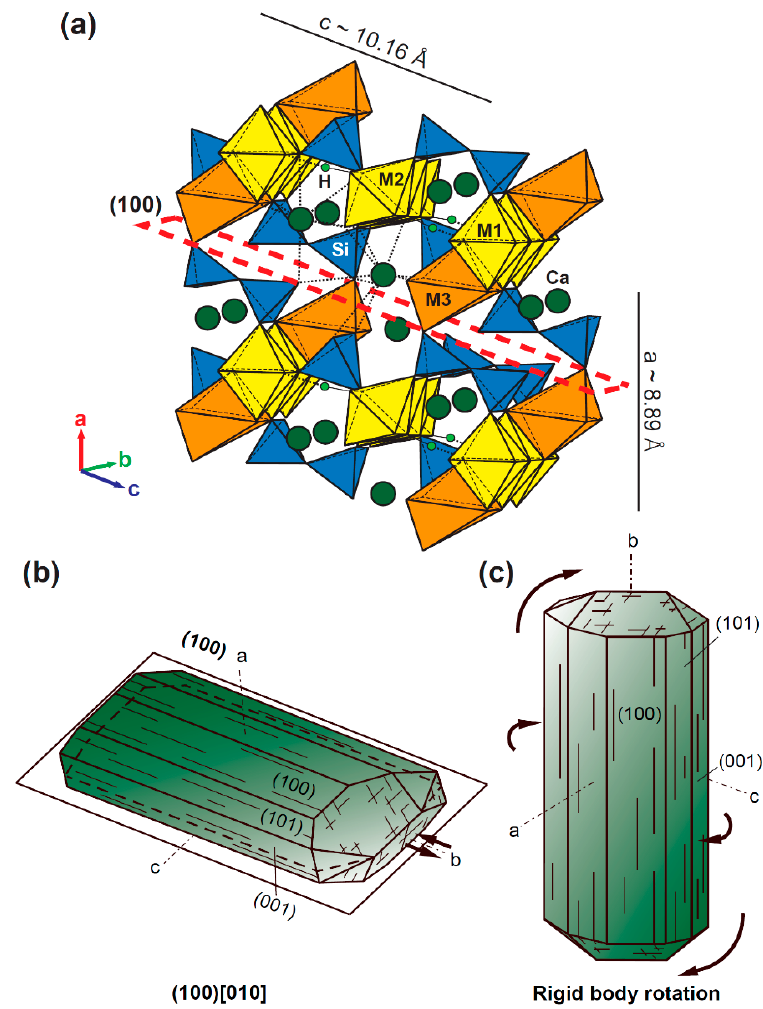
Figure 10. ( a ) Simplified epidote crystal structure. Red dashed rectangular indicate the tracks of the easiest (100) slip plane. Blue tetrahedron: Si-O structure, yellow octahedron: Al-O structure ( M1 and M2 site), orange octahedron: Al-Fe 3 + substitution-O ( M3 site), blue circle: H, and green circle: Ca ( A1 and A2 site); ( b , c ) schematic of the epidote crystal form with di ff erent behavior by slip. The transparent truncate sheet and black arrows in ( b ) indicate a dominant slip plane and a dominant slip direction, respectively. Black arrows in ( c ) indicate a direction of rigid body rotation by shear